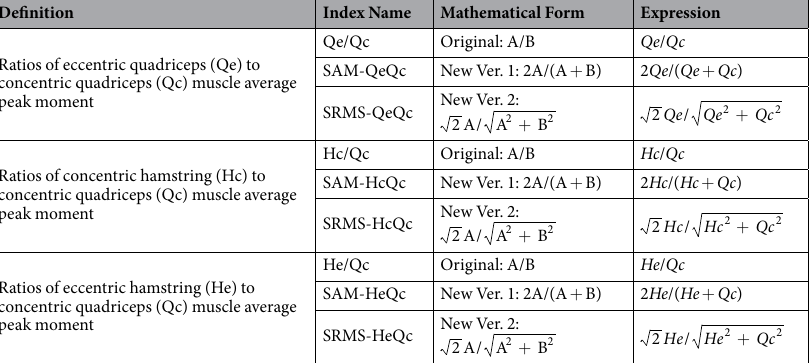
Table 1. Definition of the original H/Q Ratios and two versions of newly introduced muscle strength indices. H/Q, hamstring to quadriceps muscle strength ratio; SAM, single-to-arithmetic-mean form indices, the single muscle strength of hamstring or quadriceps to the arithmetic mean of two muscle strengths; SRMS, single-to- root-mean-square form indices, the single muscle strength of hamstring or quadriceps to the root mean square of two muscle strengths; Ver., newly introduced muscle indices version; A and B correspond to hamstring or quadriceps muscle